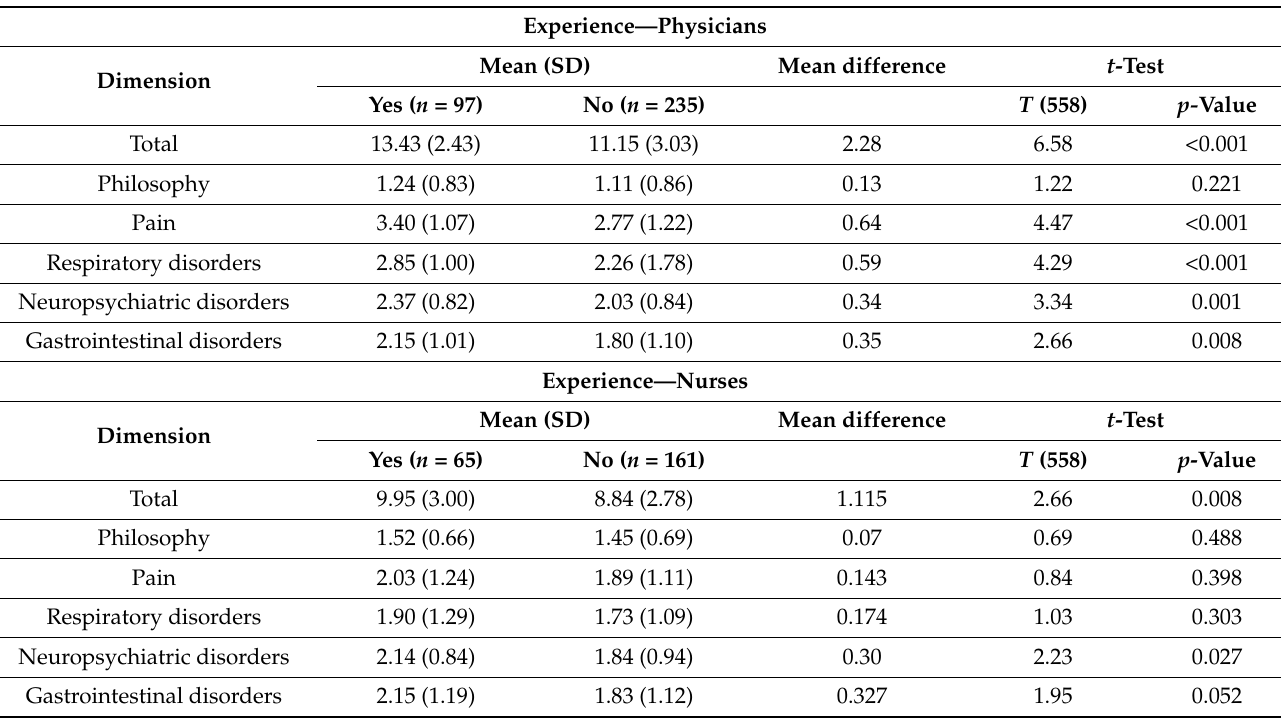
Table 5. Descriptive study and comparison of PCKT-SV scores according to previous experience in palliative care in physicians and